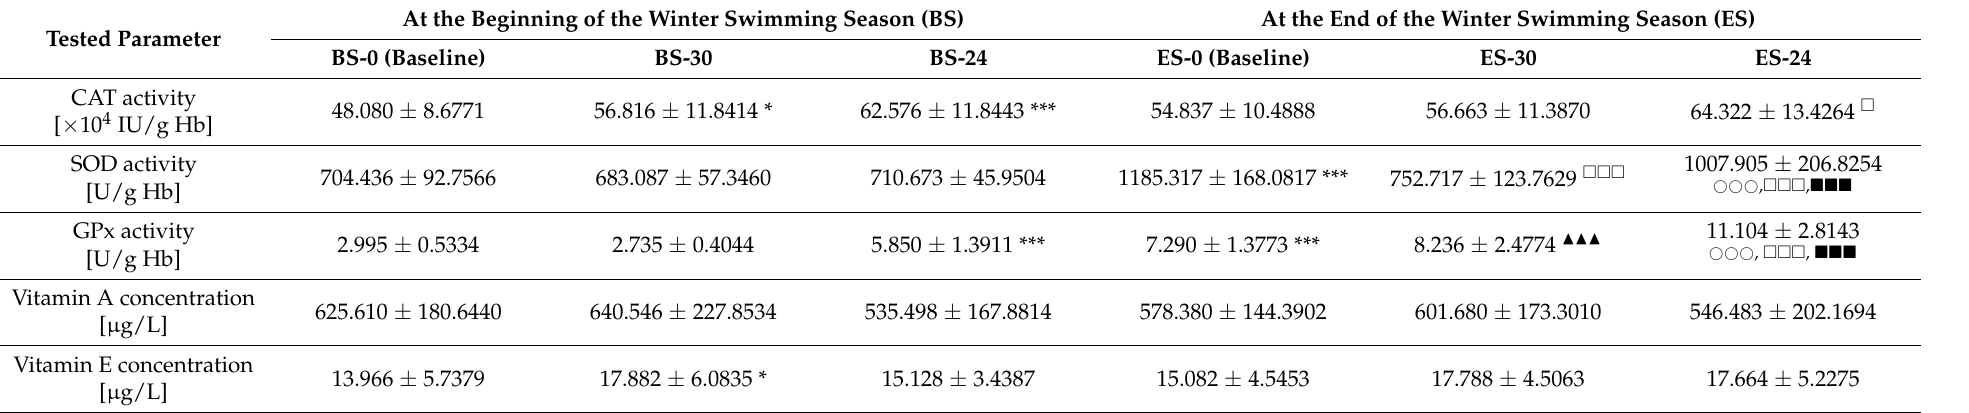
Table 4. The activity of antioxidant enzymes and the concentration of antioxidant vitamins in the blood plasma of winter swimmers. Tested